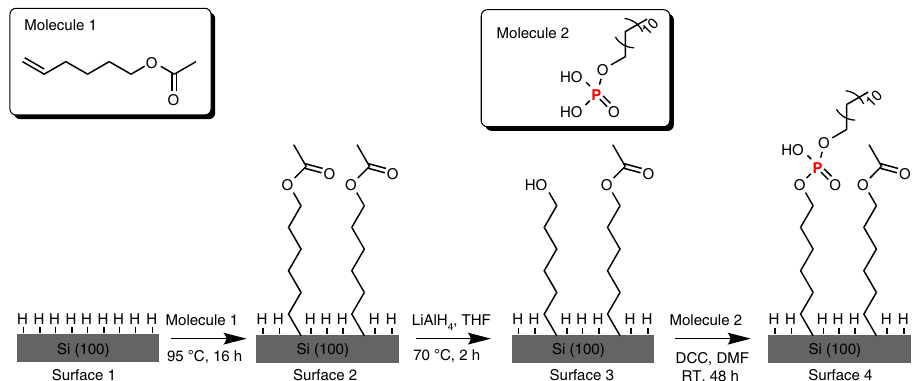
Fig. 1 Stepwise surface modi fi cation on Si (100) surfaces. Molecule 1 is chemically grafted onto surface 1 under thermal treatment at 95 °C for 16 h forming a molecular monolayer on surface 2. Molecule 2 reacts with the hydroxyl group on surface 3 leading to a phosphorus-funtionalized surface